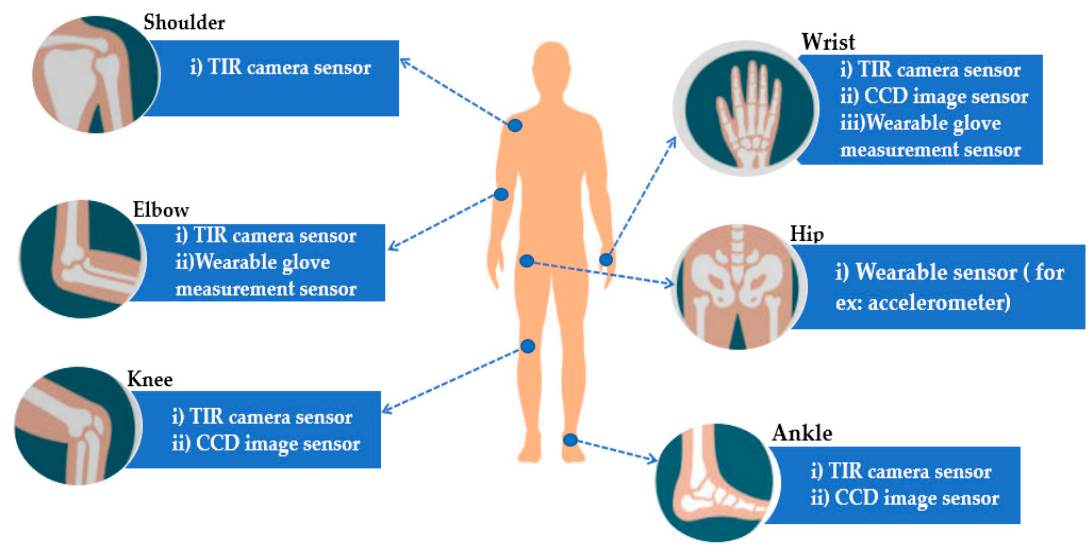
Figure 2. Sensor used for each joint.